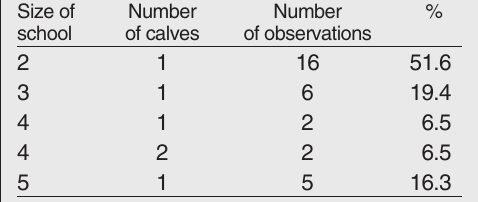
Table 4. Compositions of schools